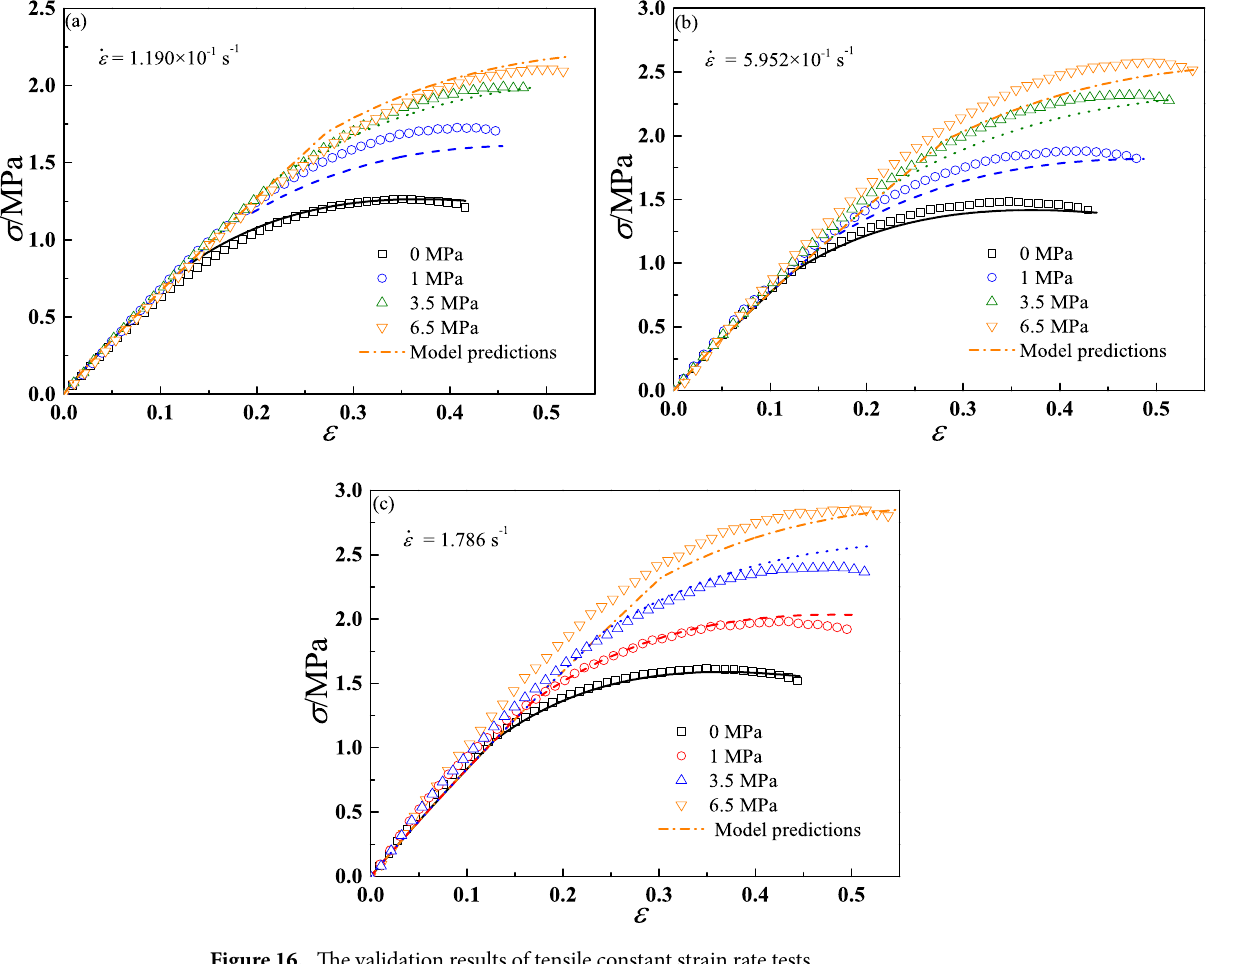
Figure 16. The validation results of tensile constant strain rate tests.